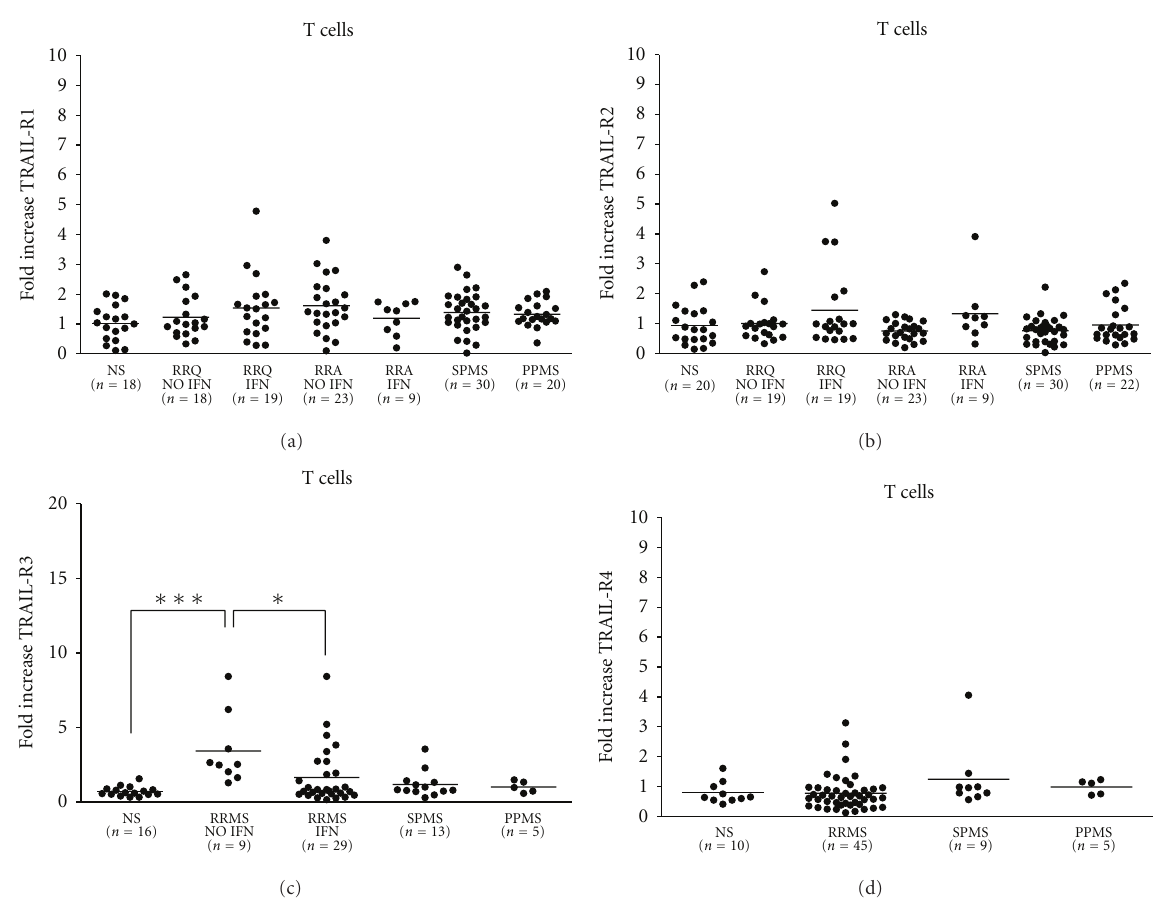
Figure 2: Relative quantification of TRAIL death (TRAIL-R1, TRAIL-R2) and decoy receptor (TRAIL-R3, TRAIL-R4) mRNAs in T cells. (a) In T cells, there were no di ff erences in gene expression of TRAIL-R1 and (b) TRAIL-R2. (c) TRAIL-R3 gene expression was increased in RRMS NO IFN patients relative to the NS group while administration of IFN- β reversed this increase in RRMS patients (RRMS IFN). ∗ P < . 05 and ∗∗ P < . 01, Dunn’s posthoc test.